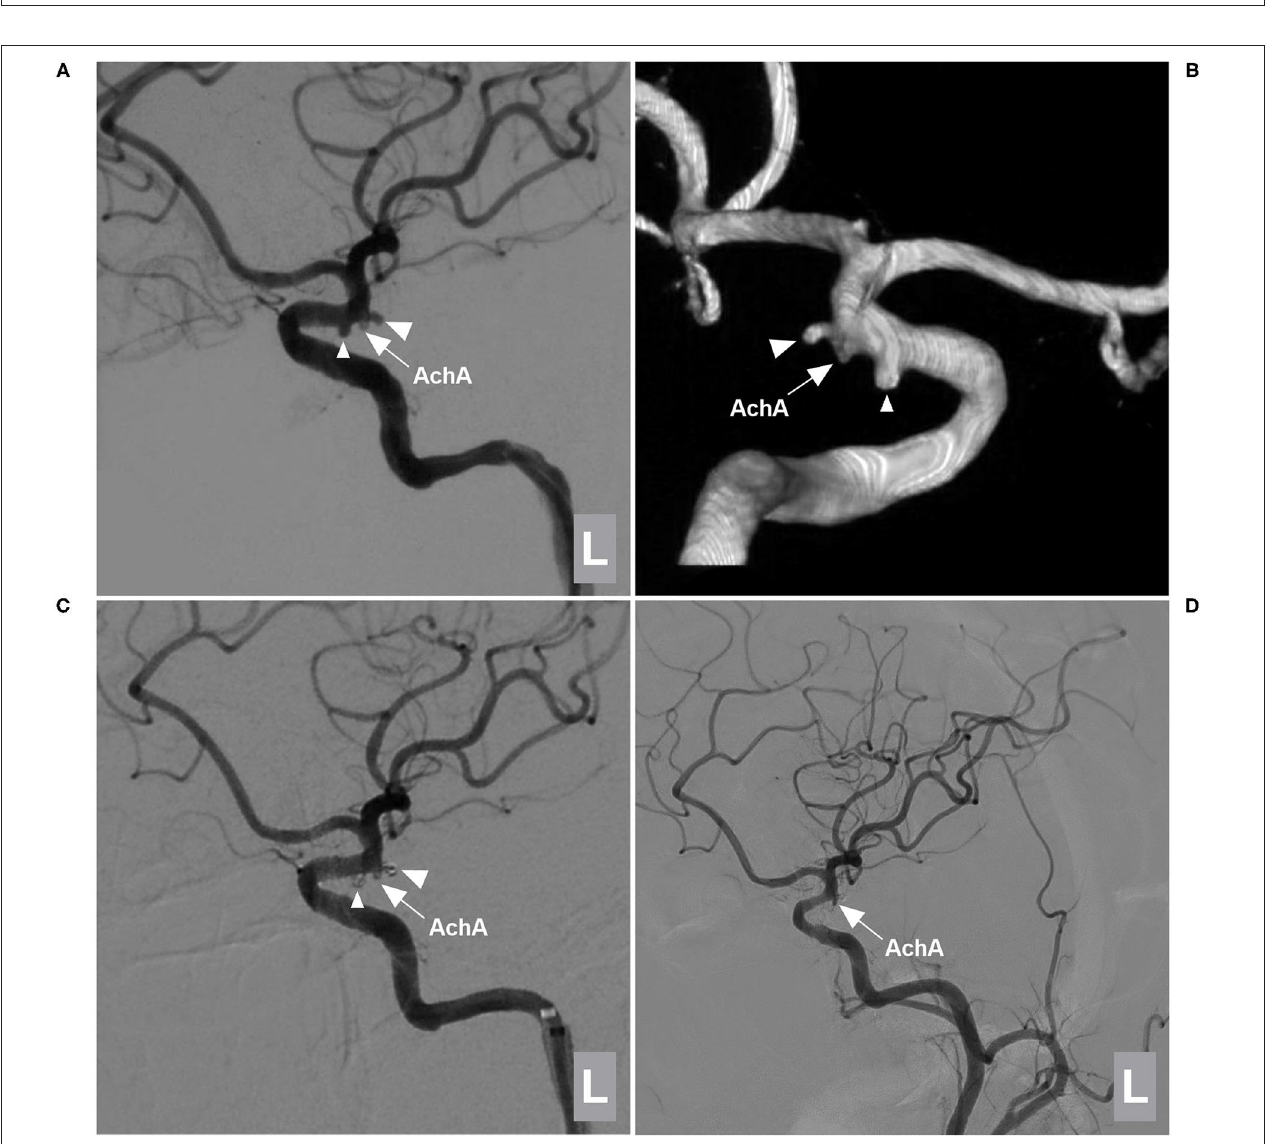
FIGURE 4 | EVT of a type I AchA aneurysm associated with PcomA aneurysm. (A,B) DSA (A) and 3D-DSA (B) of the left ICA showing the AchA (large triangle) and PcomA (small triangle) aneurysms; the arrow indicates the AchA origin is away from the aneurysm neck. (C) DSA of the left ICA showing that the two aneurysms (large and small triangles) were coiled under stent assistance and that the AchA (arrow) was intact. (D) Follow-up DSA showing no recurrence of these two aneurysms with MRCC grade I, the AchA (arrow) was shown. AchA, anterior choroidal artery; DSA, digital subtraction angiography; EVT, endovascular treatment; ICA, internal carotid artery; L, left; MRCC, Modified Raymond-Roy Classification, PcomA, posterior communicating artery, 3D,